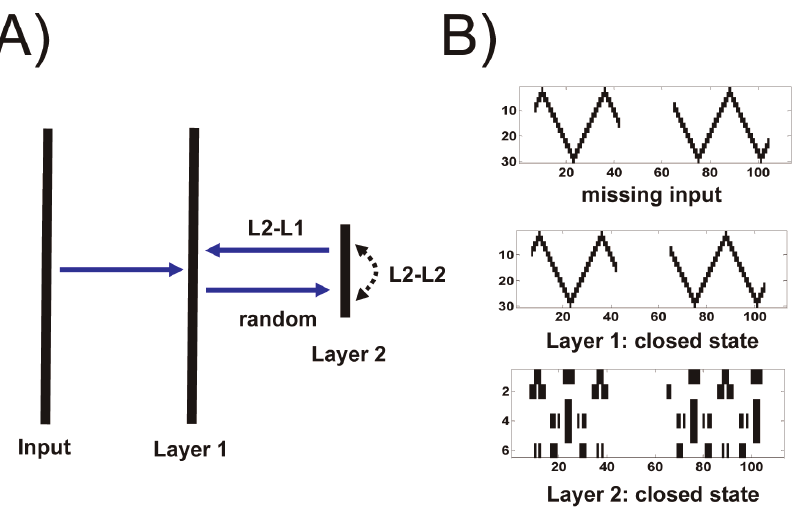
Figure 7. Hidden layer learns a low-dimensional representation of spike trains in the form of a repeating triangular wave. ( A ) The thirty neurons in layer 1 (Layer 1) are clamped to input spike trains in the form a repeating triangular wave. During the open state, these neurons project (through synaptic weights sampled from a random uniform distribution between -1 and 1) to a much smaller hidden layer (Layer 2) which in this example contains six neurons. Synaptic state matching in the intra-layer 2 synaptic connections (L2-L2) gives rise to an accurate predictive model within this hidden layer. In turn, the L2-L1 connections implement a top-down generative model in layer 1. Synaptic state matching of synapse projections from layer 2 to layer 1 (L2-L1) generates an accurate predictive model of the missing input at layer 1. Layer 1 neurons do not have any internal recurrent connections. ( B ) top: missing input into layer 1 during the closed state; middle: predicted pattern of missing input created by the projection of hidden layer axons to layer 1 during the closed state. The pattern is a perfect match to the missing input; bottom: the coincident activity of the six neurons in the hidden layer during the closed state. SSM parameter choices for both L2-L2 and L2-L1 connections were as follows: potentiation strength ( a ): 5 6 10 2 4 , spike-rate memory (m s ): 200, potentiation memory (m p ): 50, state switching period: (Gaussian, t m =30, t s =10), neuron firing threshold (V t ): 0.5, sigmoid sharpness (S): 10, latency range (L): 20.